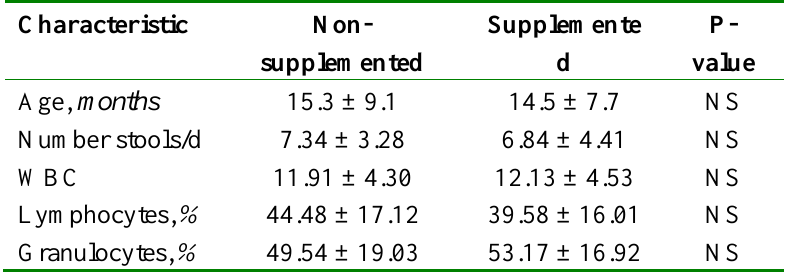
Table 1. Patients and stool characteristics upon admission. NS = not